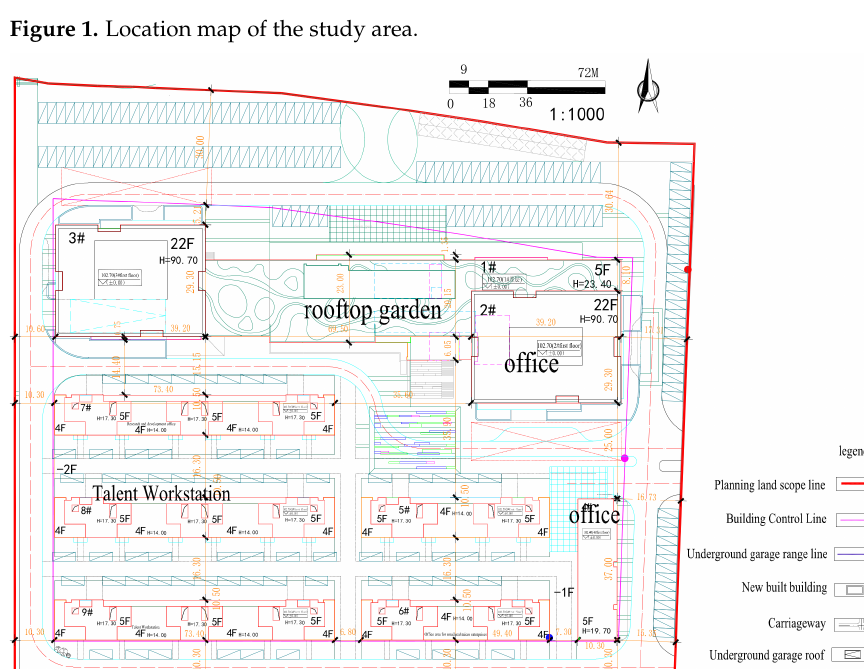
Figure 2. Layout plan of the proposed